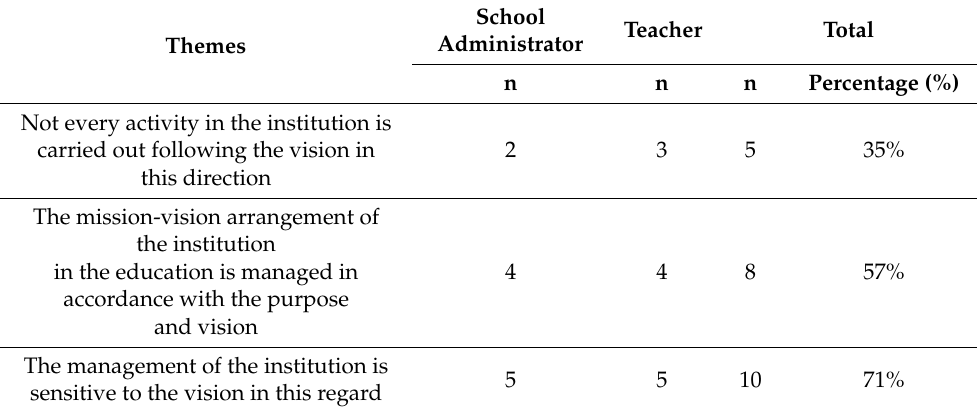
Table 1. The suitability of the institution’s inclusive educational purpose with